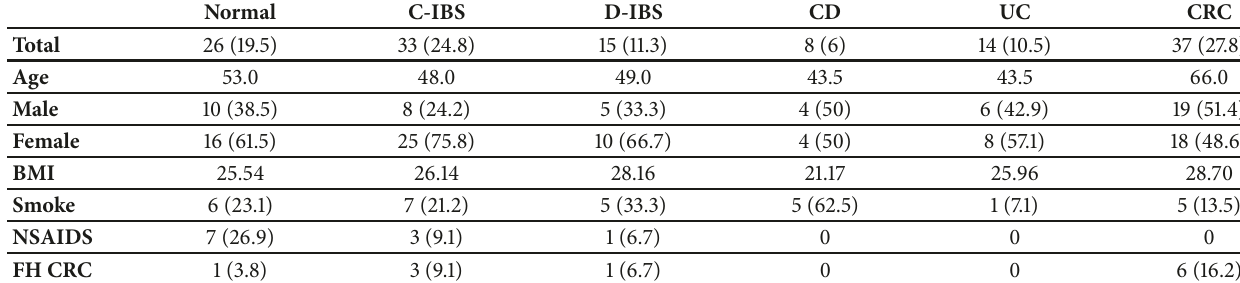
Table 2: Demographic details of study